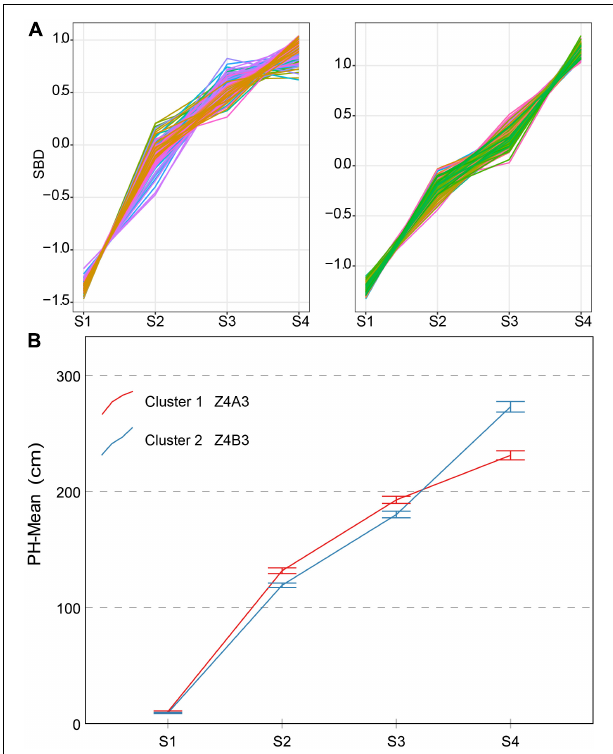
FIGURE 8 | Clustering analysis for PH time series (A) , two clusters and typical curve for PH trait (B) . (A) The horizontal X -axis represents four growth stages, and the vertical Y -axis represents the shape-based distance. (B) The horizontal X -axis represents four growth stages, and the vertical Y -axis represents the mean value of PH at a specific growth stage. Zenith point lies at the S4 growth stage and its adjacent point lies at the S3 growth stage. Typical curves are based on mean values with a 95% confidence interval. PH, plant height; SBD, shape-based distance.